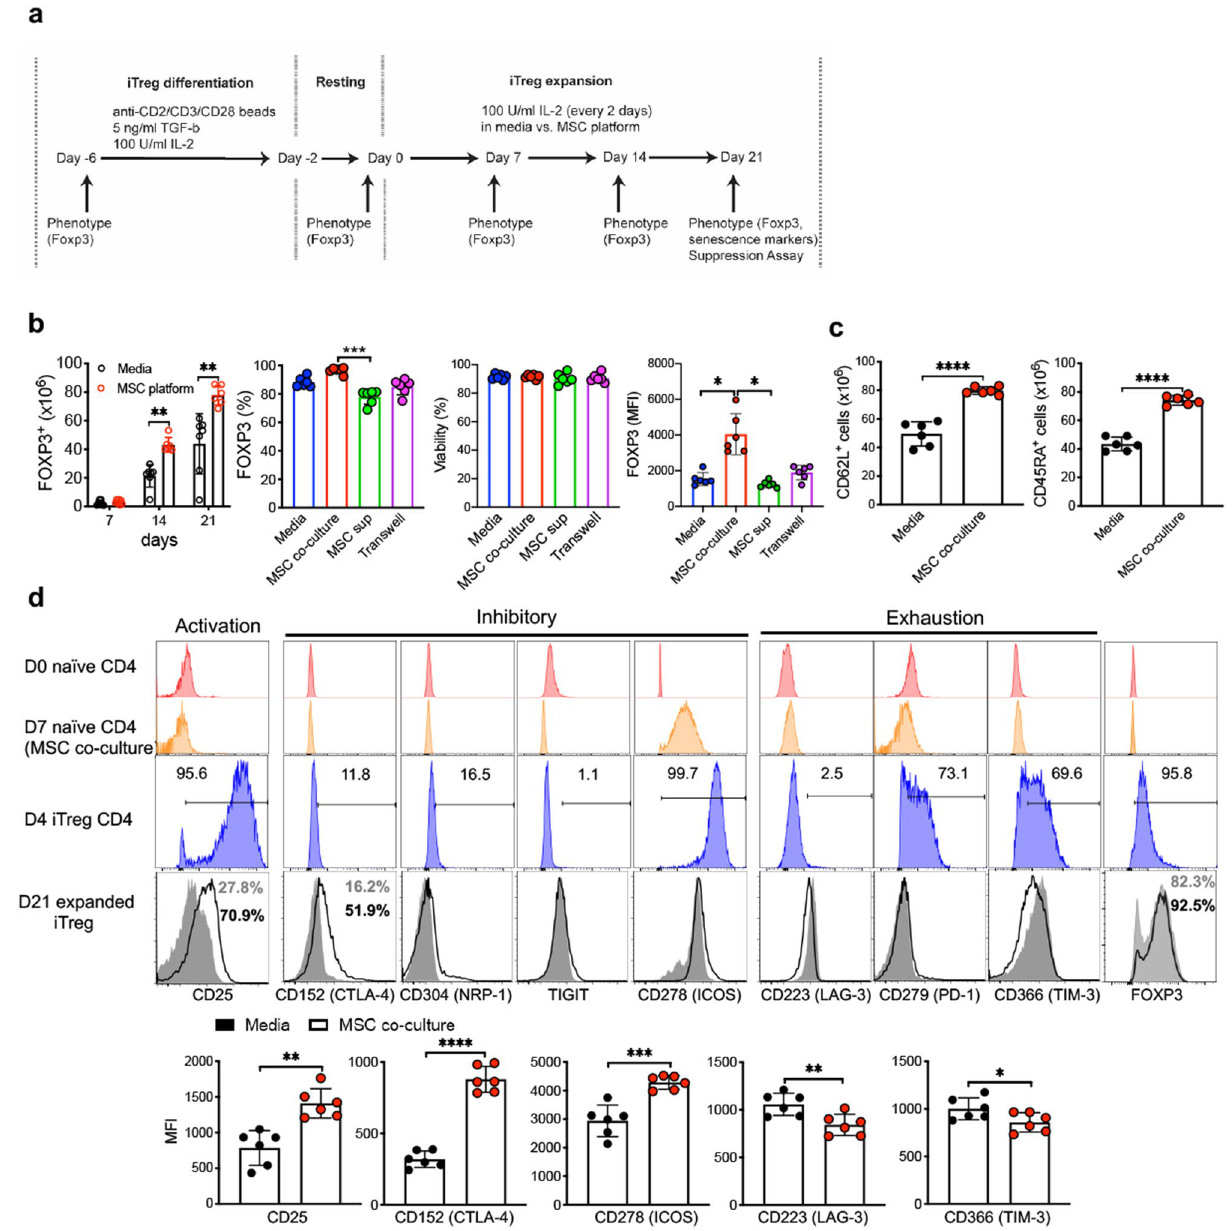
Figure 1. MSCs enhance and sustain intrinsic iTreg phenotype during IL-2 driven ex vivo expansion. ( a ) Schematic diagram shows experimental strategy for iTreg expansion. ( b ) Absolute number, percentage of FOXP3 + , FOXP3 MFI in CD4 T cells and viability of CD4 T cells at day 21 were measured at indicated time points in IL-2/media vs MSC co-culture with identical IL-2/media ( n = 6–7). Multiple comparisons analysis was performed using the Friedman test. ( c ) Absolute number of CD62L + and CD45RA + iTreg cells were calculated at 21 days expansion ( n = 5–6). ( d ) Immuno-phenotyping of Treg marker expression on D0 naïve CD4 T cells, 7 days expanded naïve T cells in IL-2/media over MSC monolayer w/o CD3/CD28 stimulation (Day 7 naïve CD4—MSC co-culture), or 4 days stimulated CD4 T cells with TGF-β/IL-2 and CD3/28—(Day 4 iTreg CD4) and iTregs included surface staining with antibodies targeting CD25, CD152 (CTLA-4), CD223 (LAG-3), CD278 (ICOS) CD304 (NRP-1), CD279 (PD-1), CD366 (Tim-3), and TIGIT at 21 days expansion. Data are representative of three independent experiments ± SD. * p < 0.05, ** p < 0.01, *** p < 0.001, **** p < 0.0001 paired t test. See also Supplementary Fig.